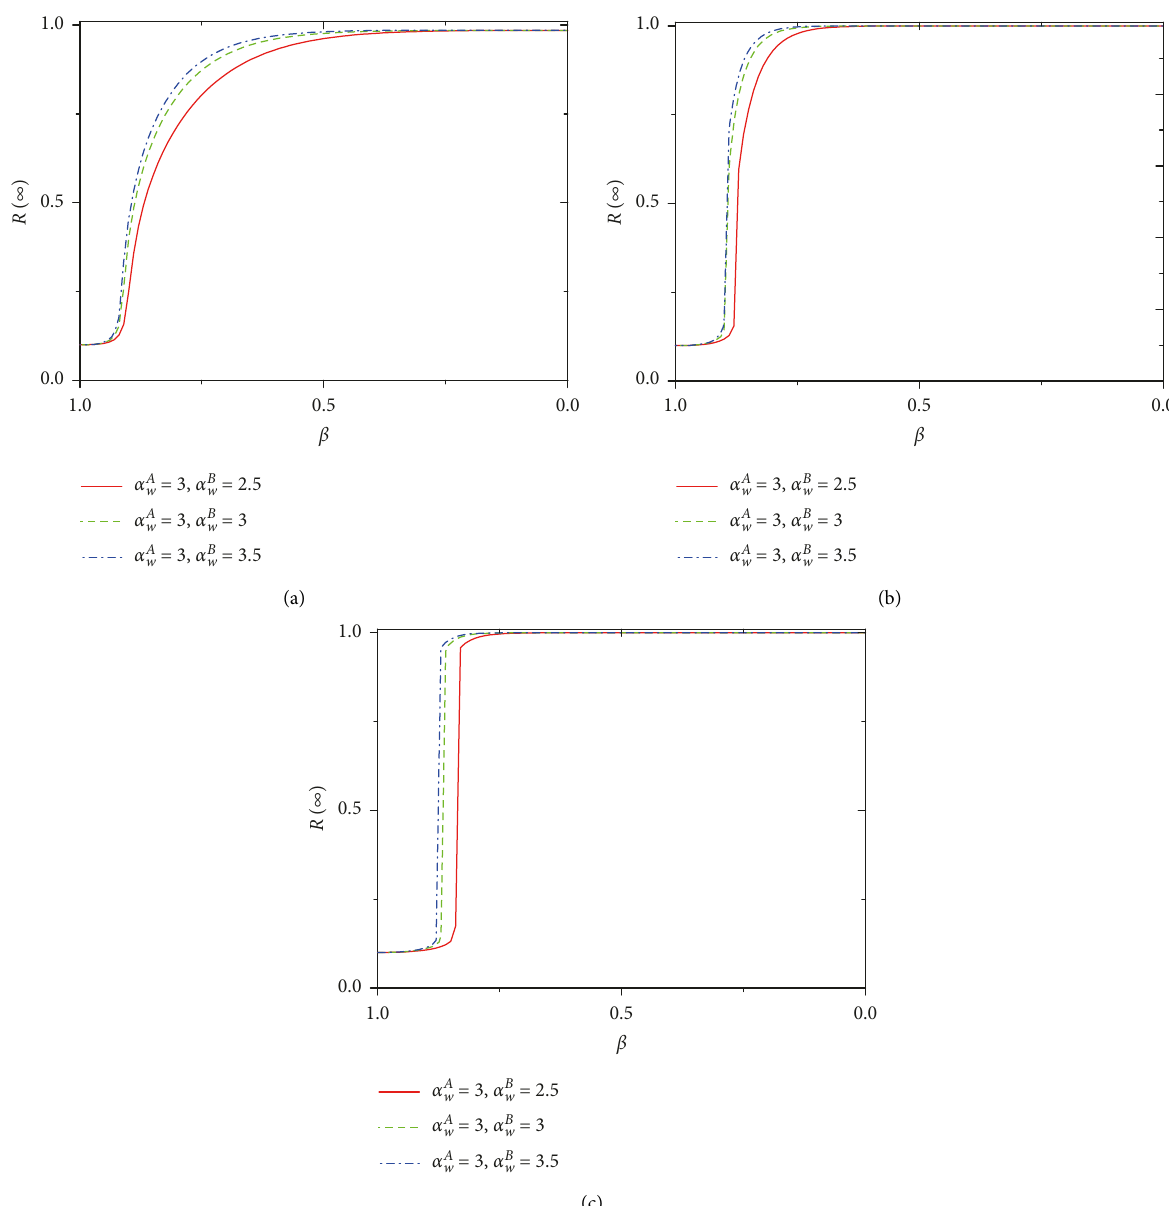
Figure 6: Effect of degree distribution heterogeneity on the final adoption size R ( ∞ ) versus β on the ER-SF weighted multiplex network with different degree distribution exponents v B . Subgraphs (a) ( v B � 2 . 1), (b) ( v B � 3), and (c) ( v B � 4) illustrate the growth patterns of R ( ∞ ) versus β under different weight distribution exponents ( α A